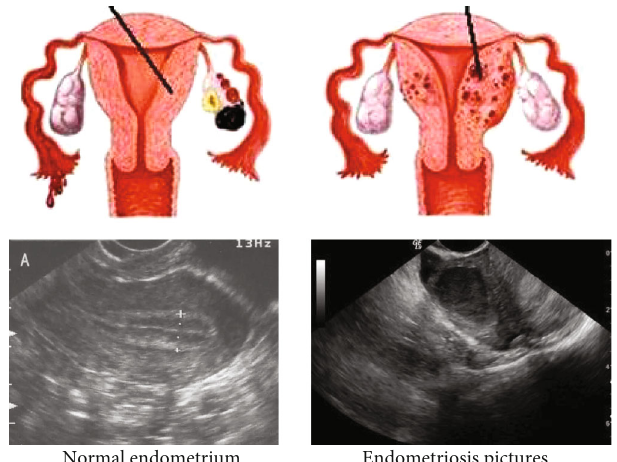
Figure 4: Comparison of normal endometrium and